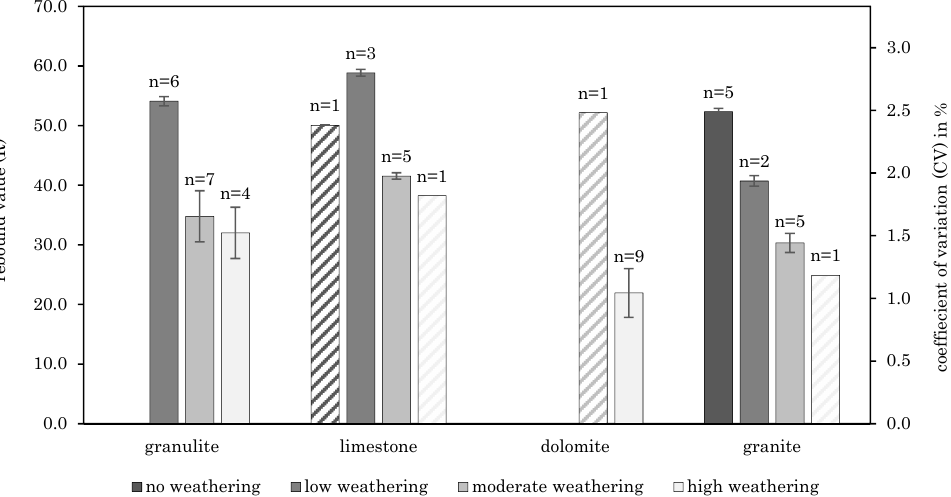
Figure 6. Relation between joint weathering and R including CV (if n = 1 no CV is given and the beams are hatched as the data can contain an outlier). Table 4. Standard deviations for Figures 4 and 6.